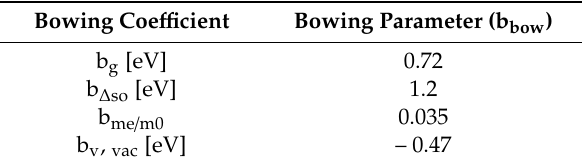
Table 2. Bowing parameter assumed in simulations ( T = 230